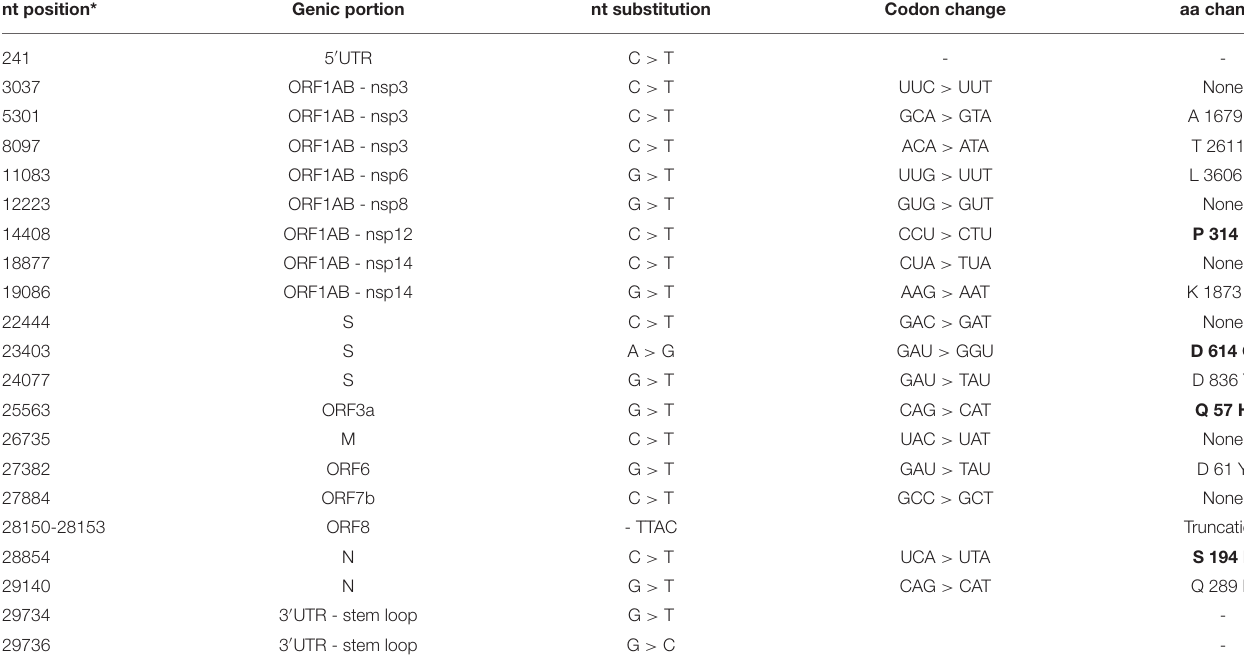
TABLE 1 | Analysis of 310 SARS-CoV-2 genome substitutions as compared to SARS-CoV-2 reference. nt